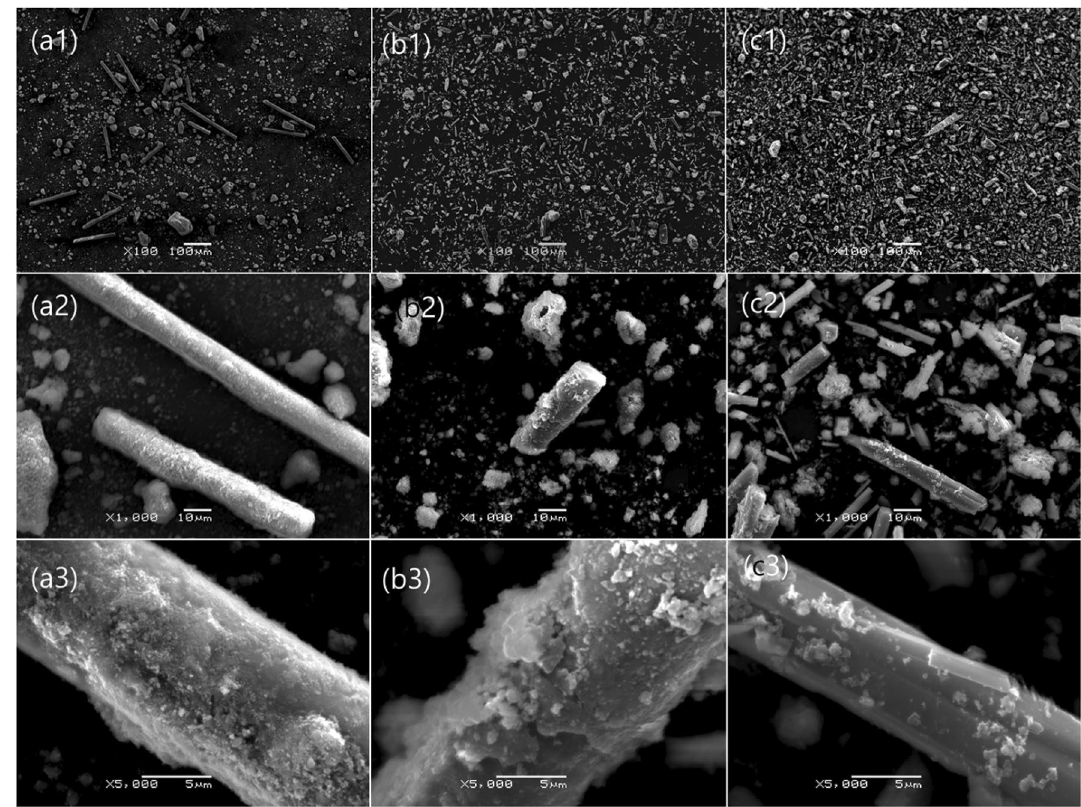
Figure 4. SEM images of ( a ) raw spent SCR catalyst, ( b ) soda roasted spent SCR catalyst and ( c ) residue obtained when water leaching was conducted at 298 K.